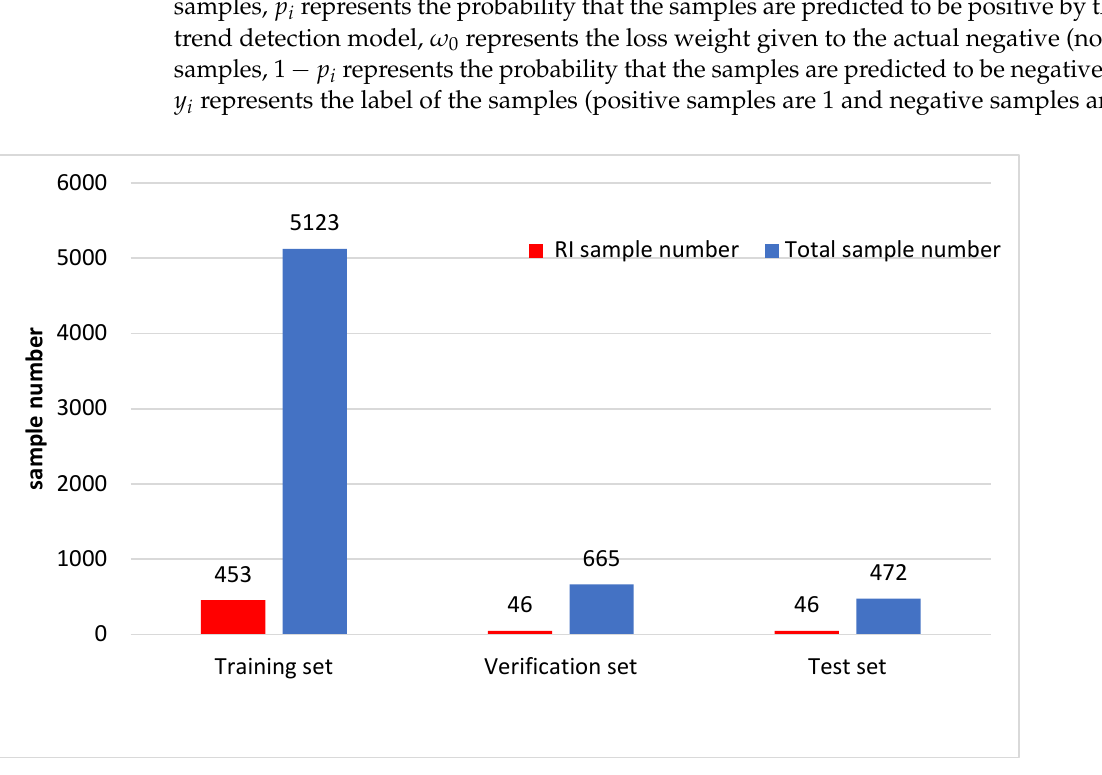
Figure 2. Data set sample distribution map.